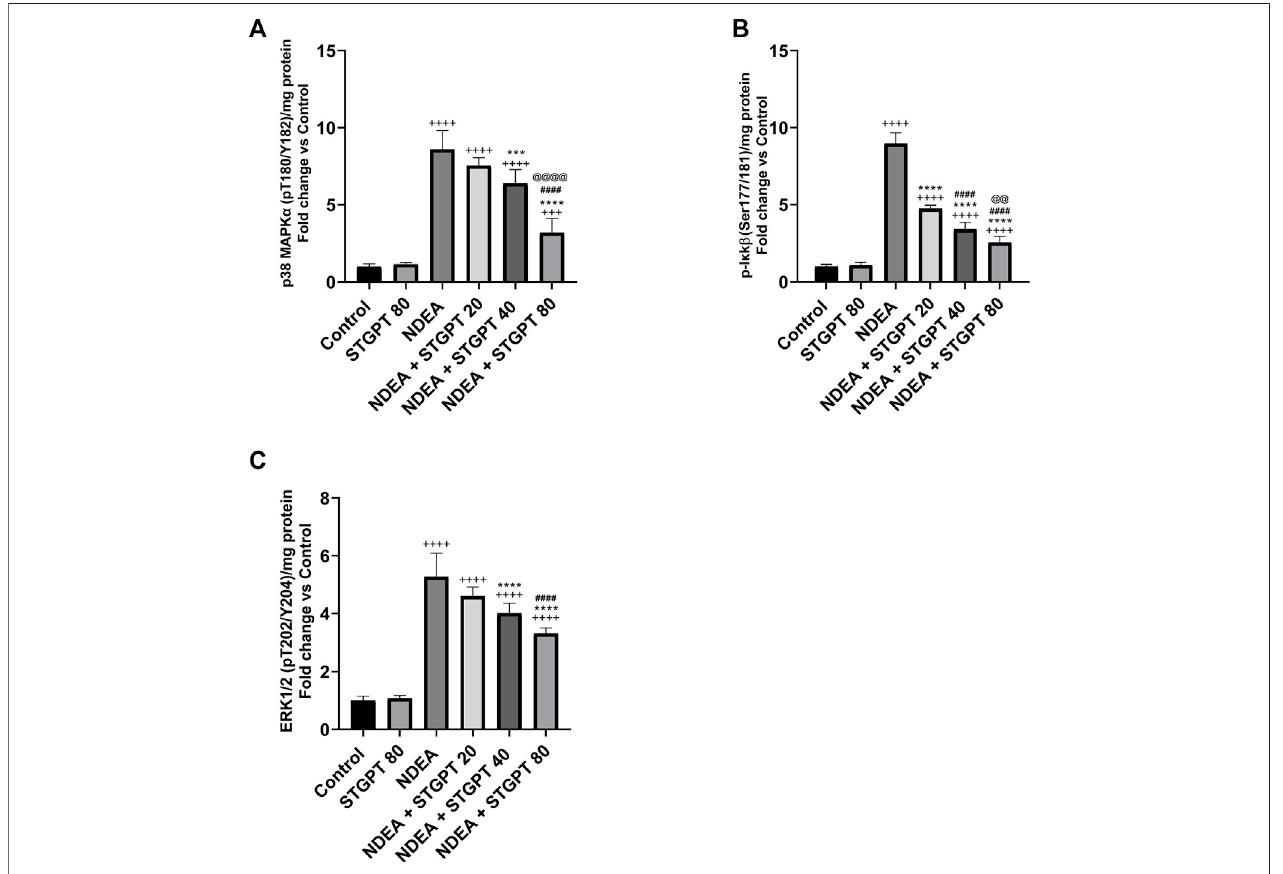
FIGURE7| Effect ofSTGPT (20,40and80 mg/kg) onp-p38MAPK α (A) ;p-Ikk β (B) ;and ERK1/2 (C) inmice withNDEA-induced HCC. Dataarepresented asthe mean ± SD ( n (cid:1) 6). +++ p < 0.001 vs. Control group, ++++ p < 0.0001 vs. Control group, *** p < 0.001 vs. NDEA group, **** p < 0.0001 vs. NDEA group, #### p < 0.0001 vs. STGPT20group, @@ p < 0.01 vs. STGPT 40group, @@@@ p < 0.0001 vs. STGPT 40 group. Control, normal control group received the vehicle; STGPT 80, normal group received sitagliptin (80 mg/kg); NDEA, NDEA-induced HCC group received the vehicle; NDEA + STGPT 20, NDEA-induced HCC group treated with sitagliptin (20 mg/kg); NDEA + STGPT 40, NDEA-induced HCC group treated with sitagliptin (40 mg/kg); NDEA + STGPT 80, NDEA-induced HCC group treated with sitagliptin (80